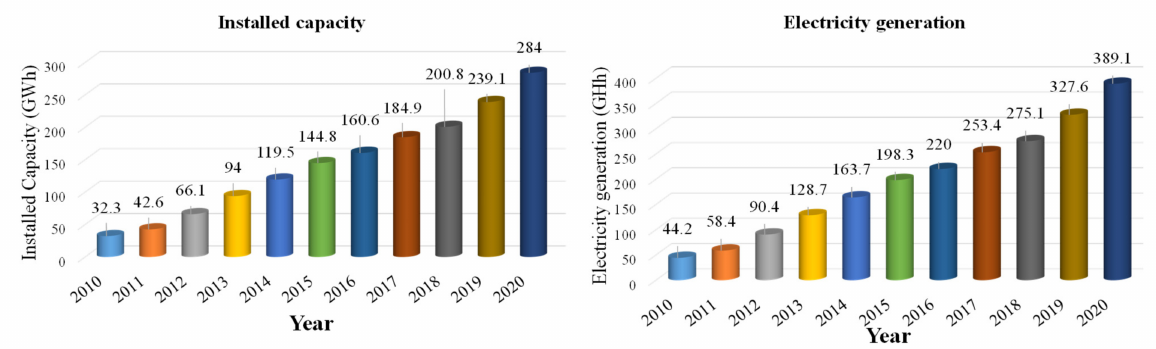
Figure 4. Historical solar energy installed capacity and electricity generation in Bangladesh